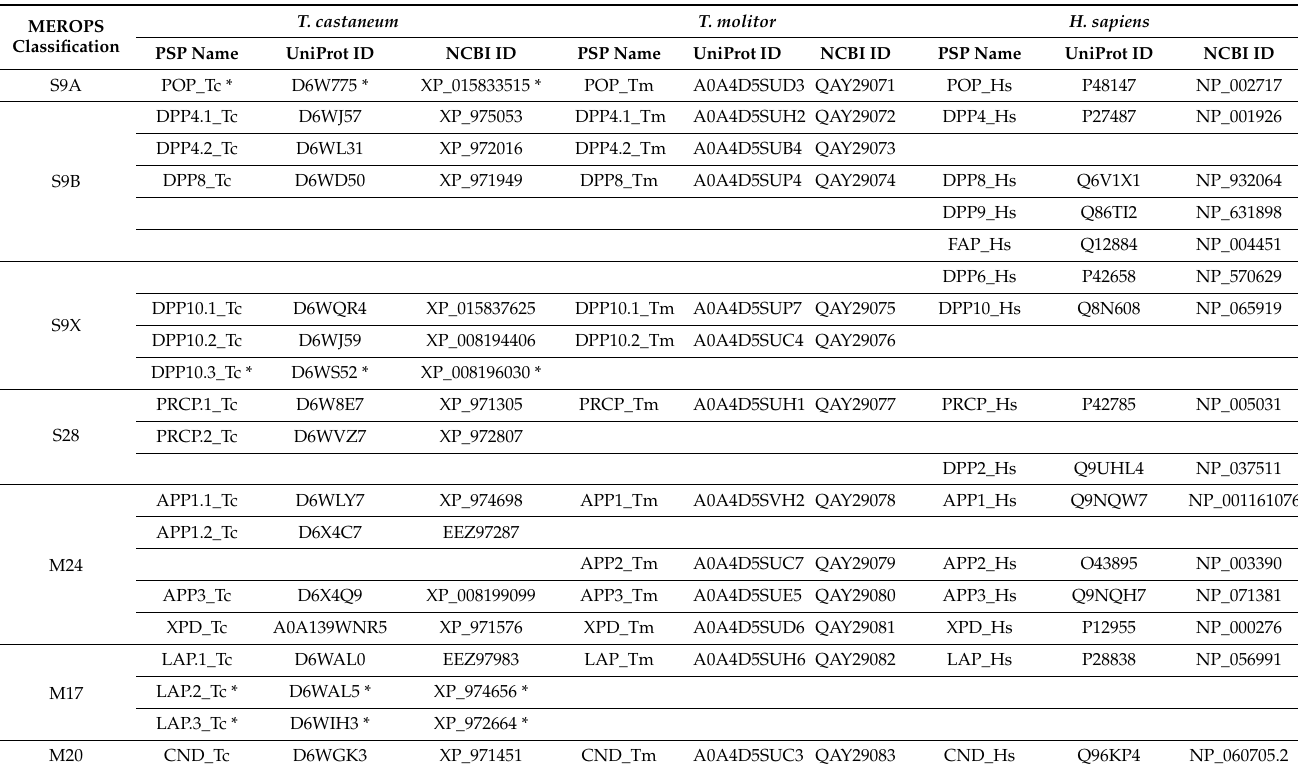
Table 1. Classification of PSPs found in the T. castaneum genome and gut transcriptome and the T. molitor gut transcriptome compared with human